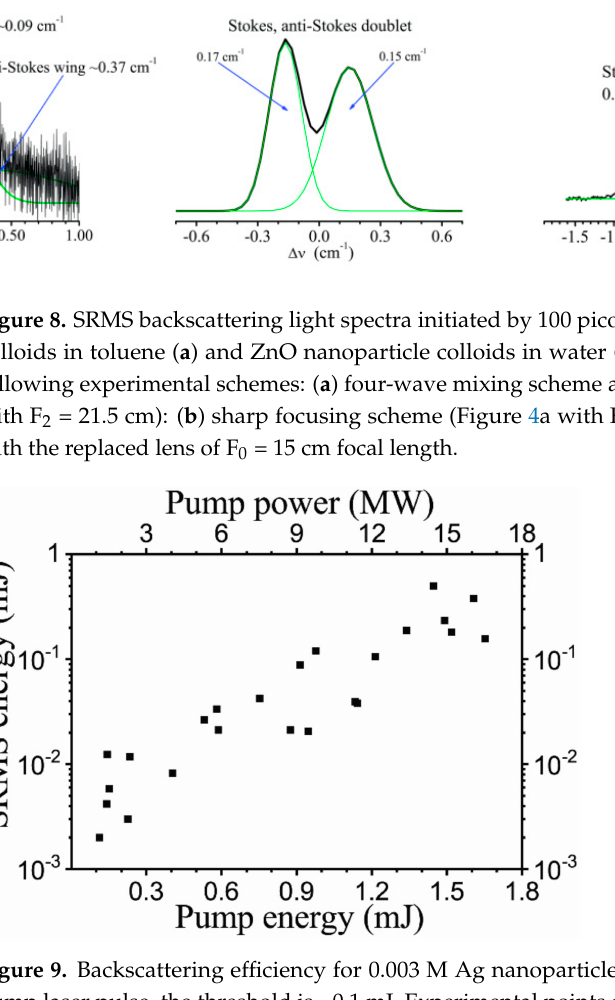
Figure 9. Backscattering efficiency for 0.003 M Ag nanoparticle solution in toluene for the 100 ps pump laser pulse, the threshold is ~0.1 mJ. Experimental points are shown by rectangles.